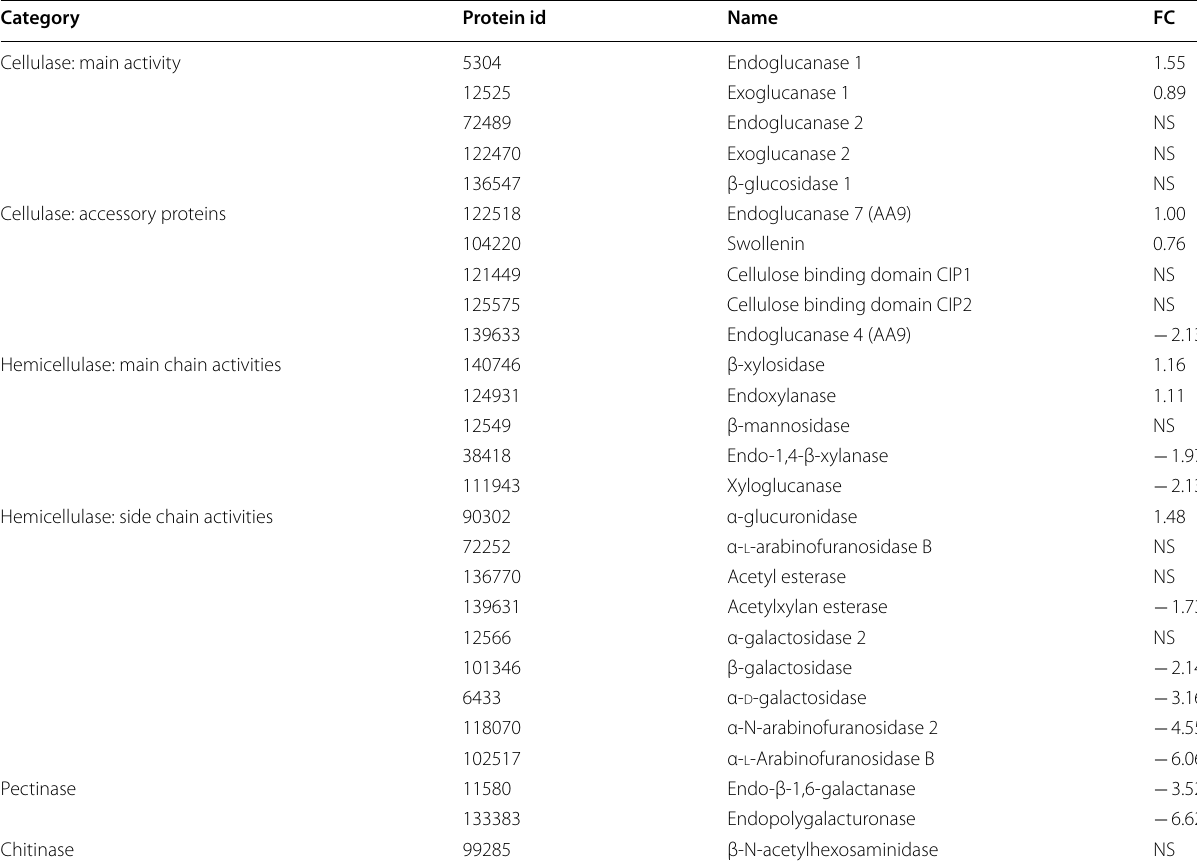
Table 2 Log -fold change (FC) of the main secreted lignocellulases expressed in MGD/lactose 2